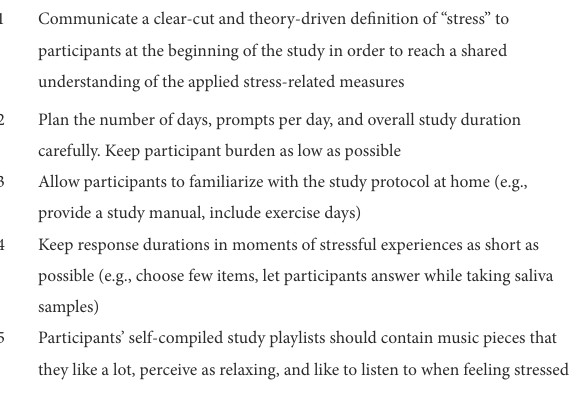
TABLE 3 Key recommendations for the design of just-in-time EM(M)Is for the reduction of acute